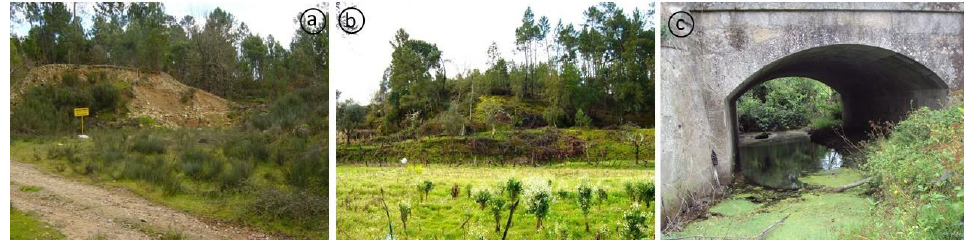
Figure 3. Topographic features from the study area: ( a ) the mine ’ s dump; ( b ) local crops; ( c ) Cagavaio river.